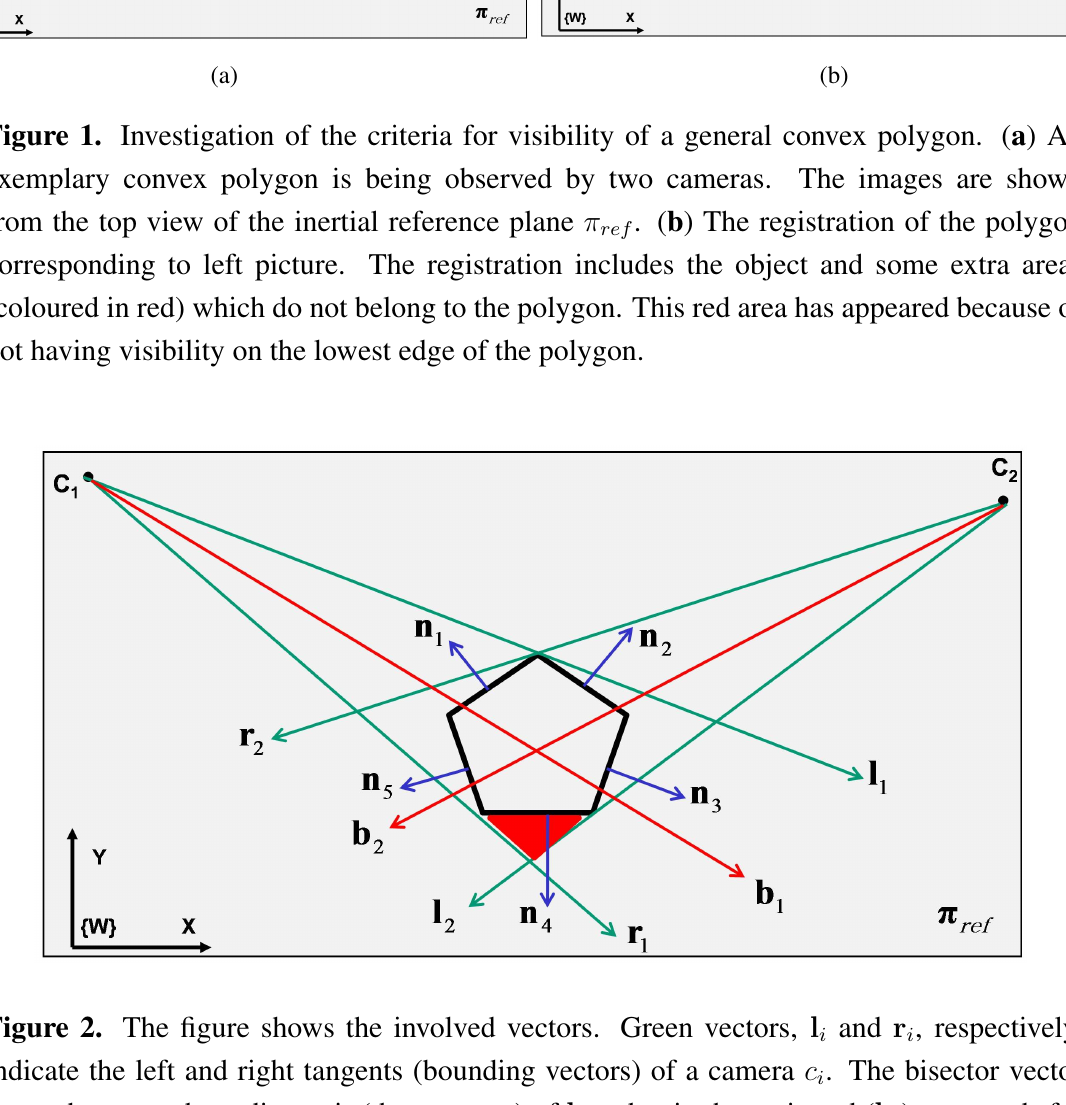
. After performing the registration process based on the proposed i